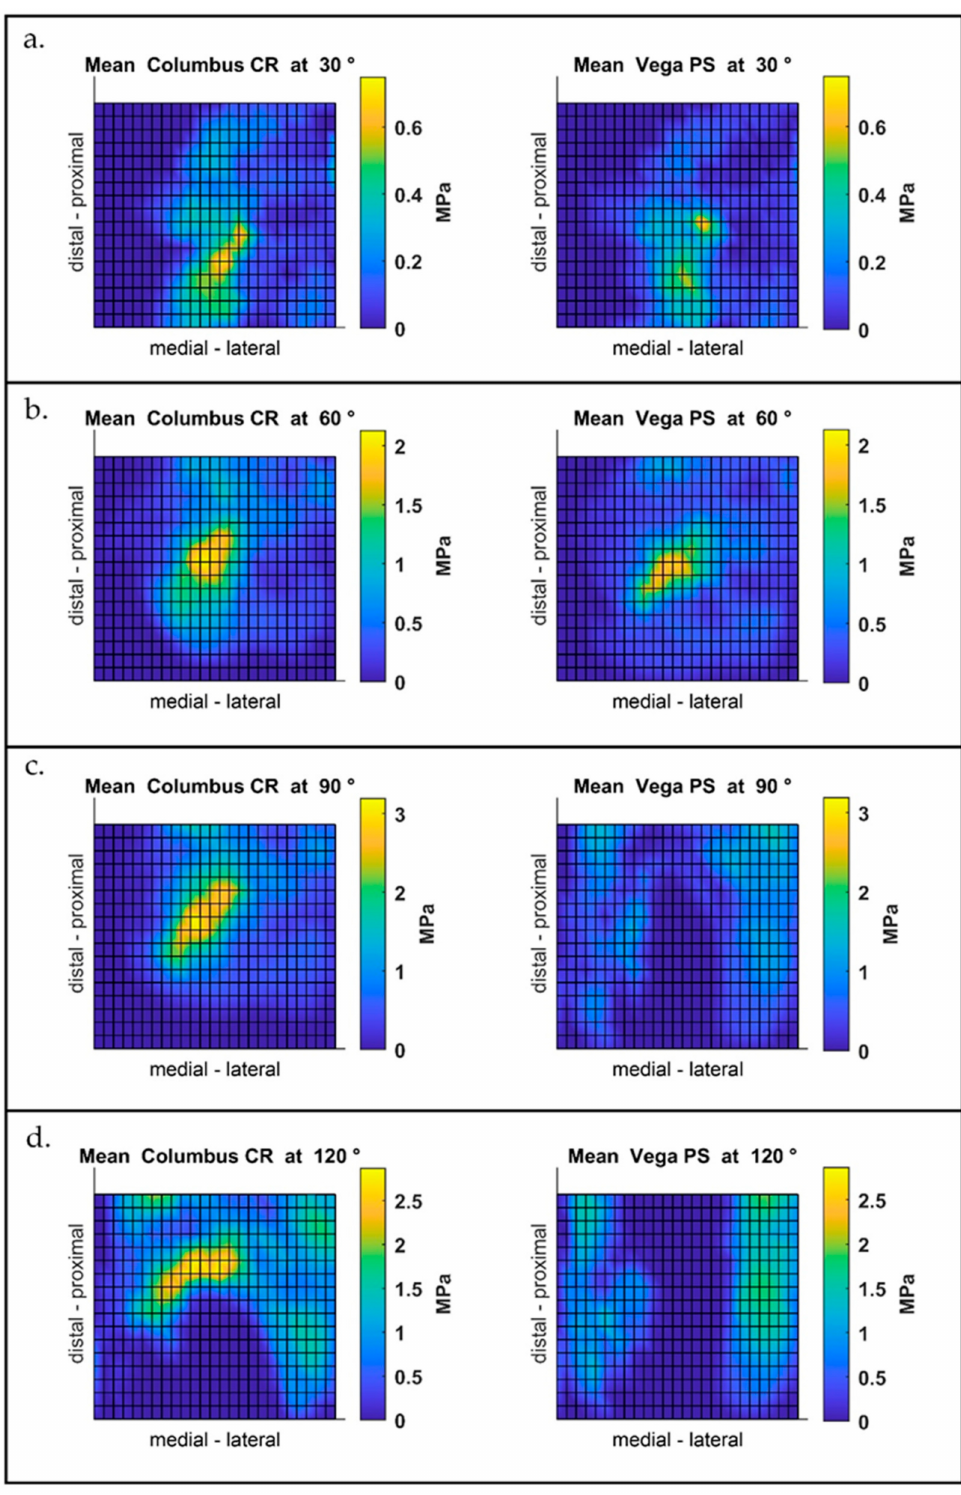
Figure 1. Mean pressure profiles of all specimens ( n = 8) for four flexion angles (( a ) 30 ◦ , ( b ) 60 ◦ , ( c ). 90 ◦ , ( d ). 120 ◦ ). Left: Columbus cruciate retaining (CR). Right: Vega posterior stabilized